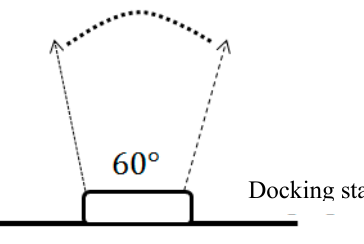
Docking station Docking station Docking station Figure 4. Exiting range of infrared light. Figure 4. Exiting range of infrared light. Figure 4. Exiting range of infrared light. Figure 4. Exiting range of infrared light.